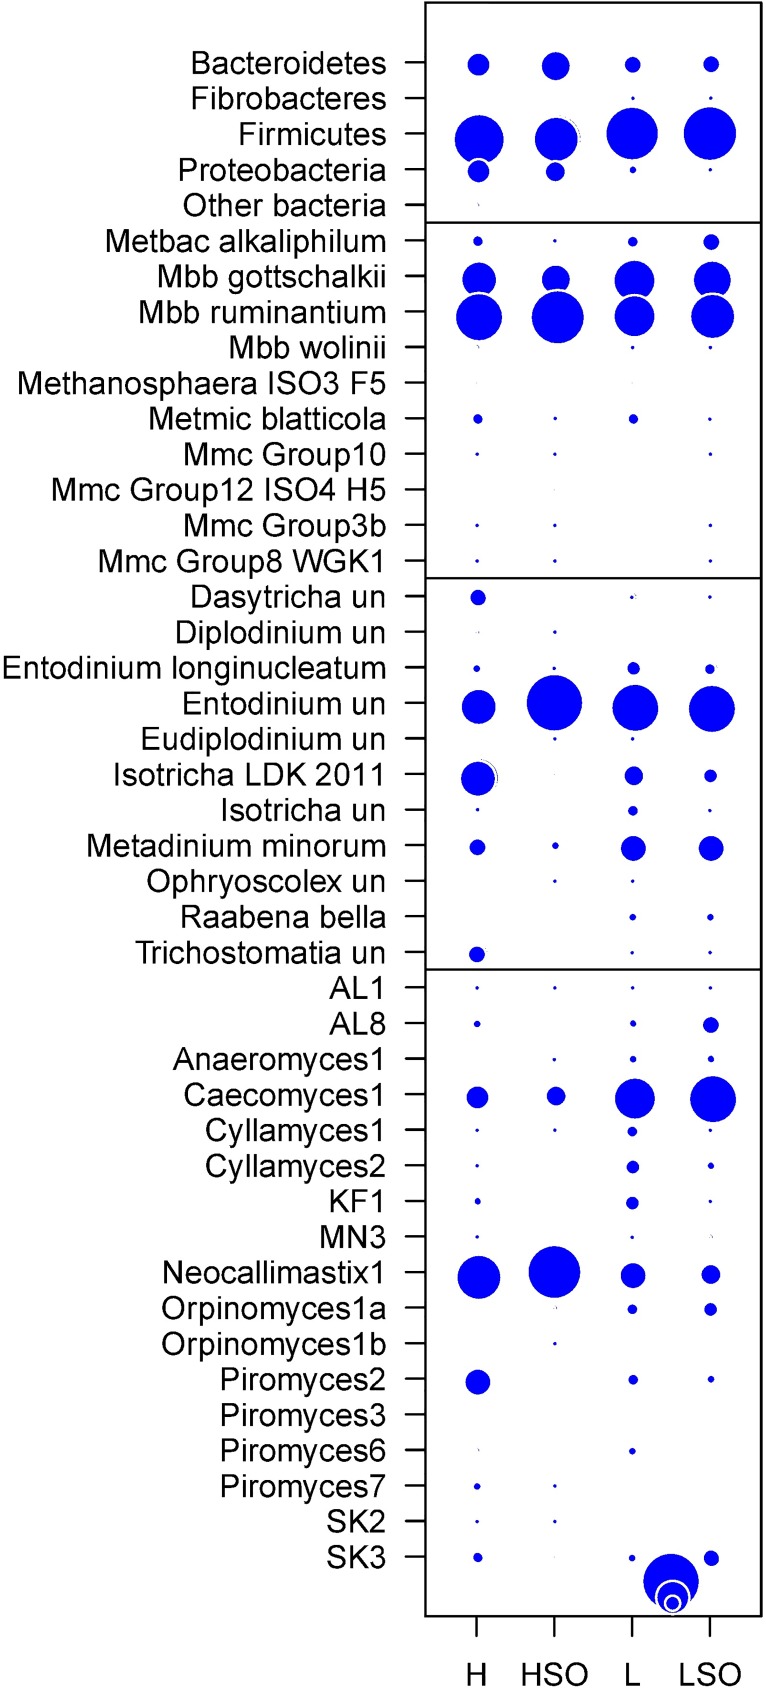
Relative abundance of bacteria, archaea, ciliate protozoa and fungi among diets.Bubble-charts represent taxonomy at the phylum level for bacteria and genus level for the rest. Diets are as follows: high (H) or low (L) proportion of concentrates without oil, or supplemented with SO (HSO and LSO, respectively).